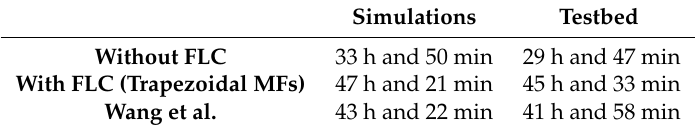
Table 3. Battery lifetime obtained from simulations and measured in the